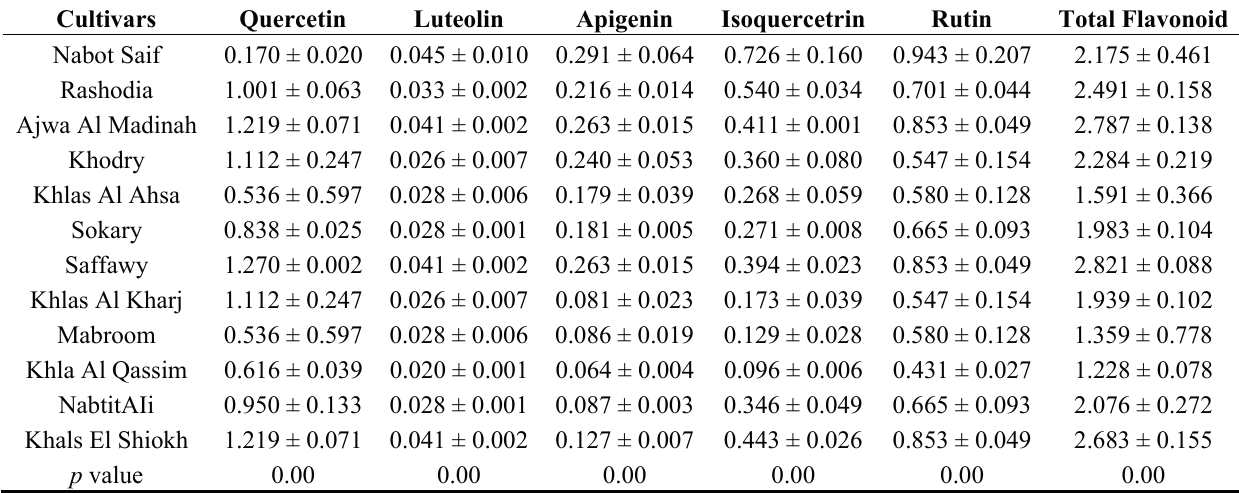
Table 5. Concentrations of flavonoid compounds (mg/100 g DW) in 12 Saudi date